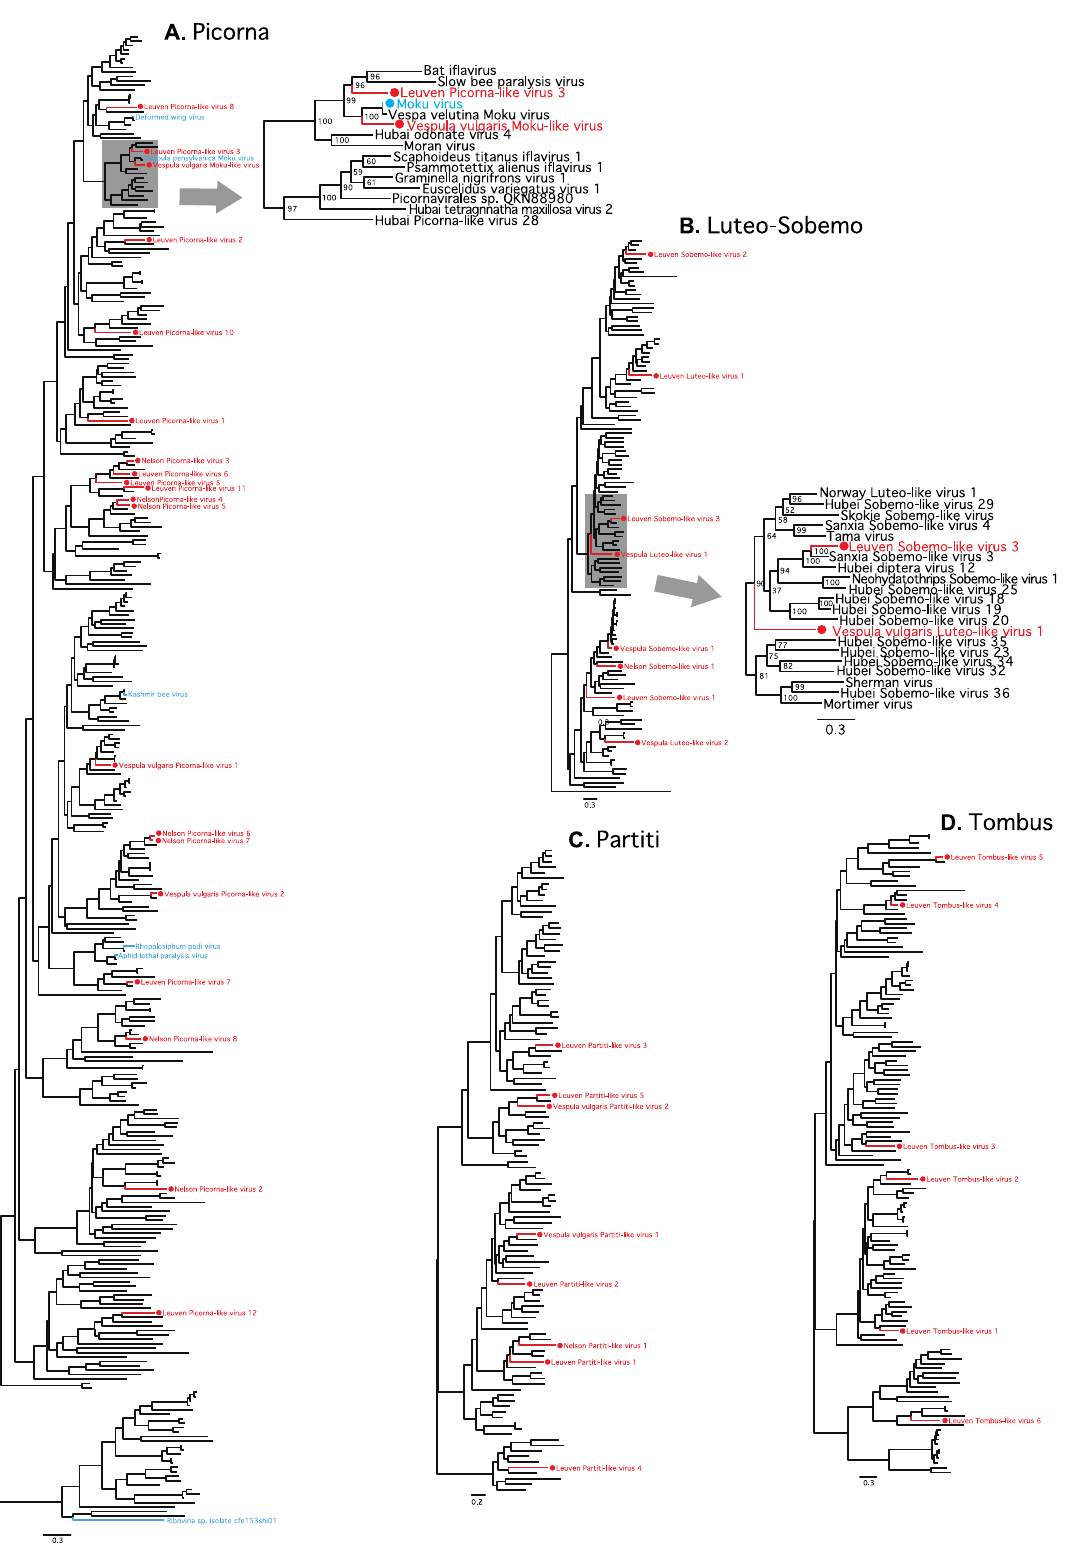
Figure 2. Evolutionary relationships of novel viruses. Shown are maximum likelihood phylogenies from viral families representing the majority of the novel viruses identified in this study (red). ( A ) Picorna. Twenty of the 24 novel Picornaviruses identified (four genomes were incomplete over the RdRp region used for alignment and were thus excluded from the analysis). Six previously identified picornaviruses also present in the samples are indicated (blue). Zoom shows the region of the tree containing the novel Vespula vulgaris Moku-like virus ( B ) Luteo-Sobemo. Eight novel Luteo-Sobemo viruses identified. Zoom shows the region of the tree containing the novel Vespula vulgaris Luteo-like virus 1. ( C ) Partiti. Eight novel Partiti viruses identified. ( D ) Tombus. Six novel Tombus viruses identified. (See Figures S1–S4 for full phylogenetic